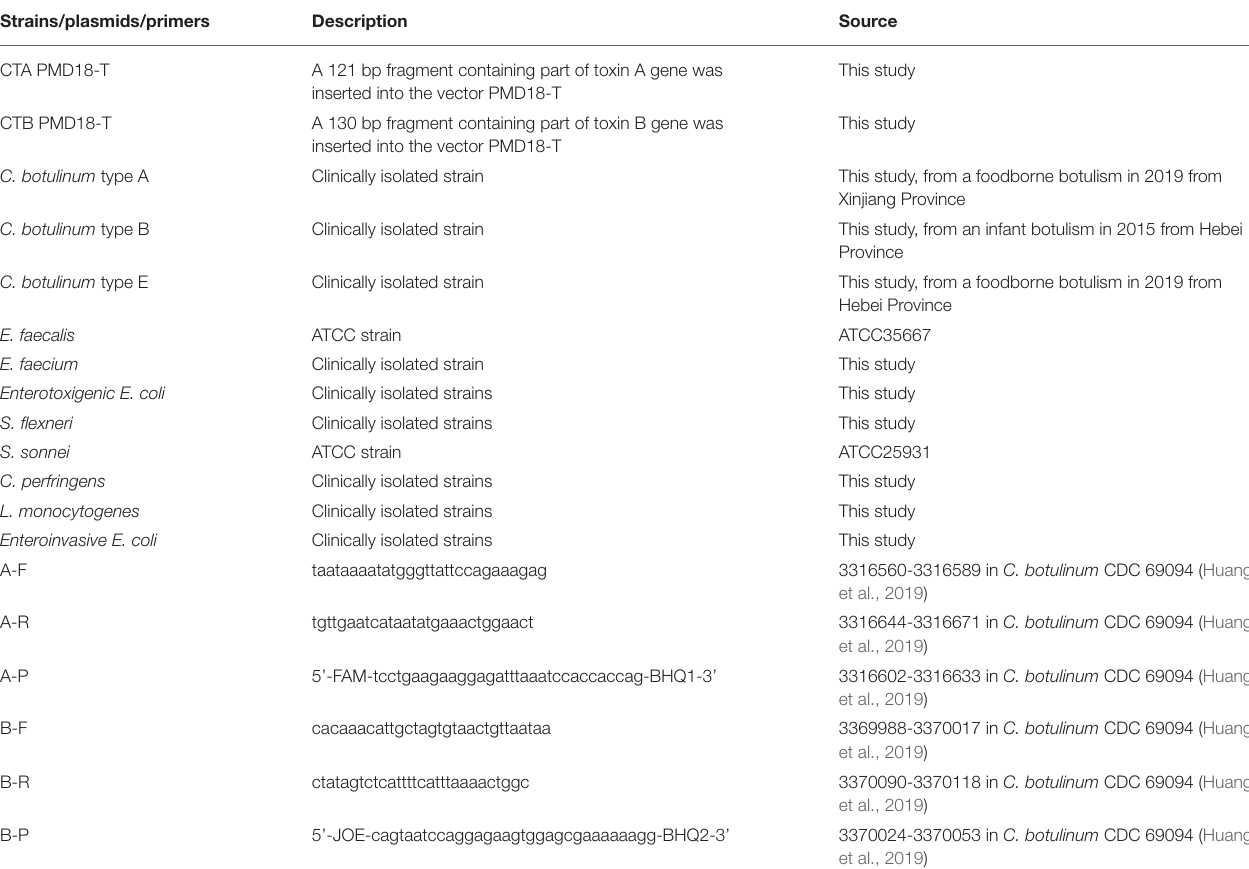
TABLE 1 | Strains, plasmids, and primers used in this